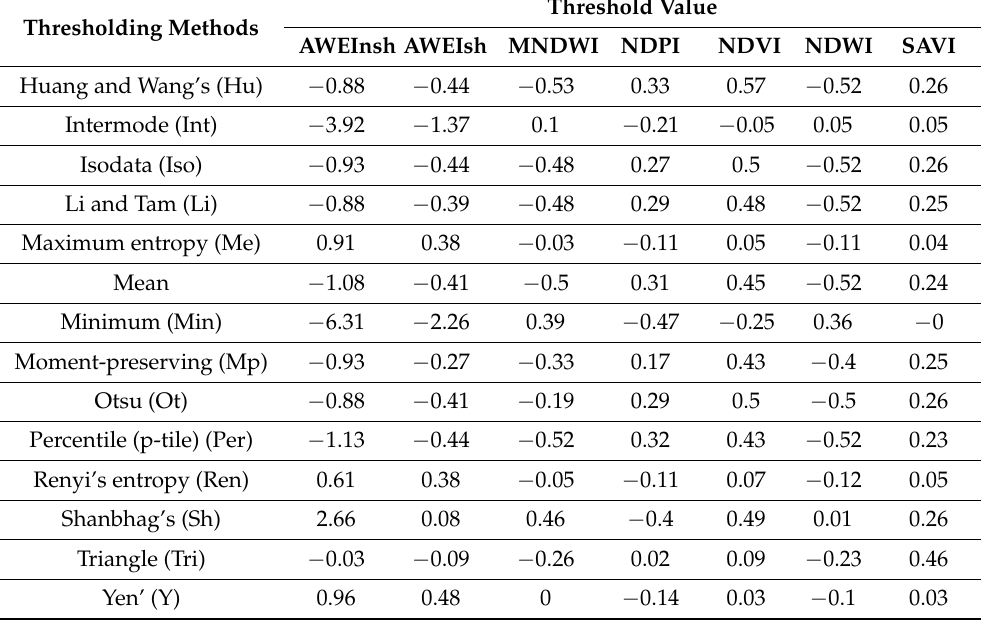
Figure 9. Accuracy values plotted for each index and mapping method by Overall and Kappa algorithms.